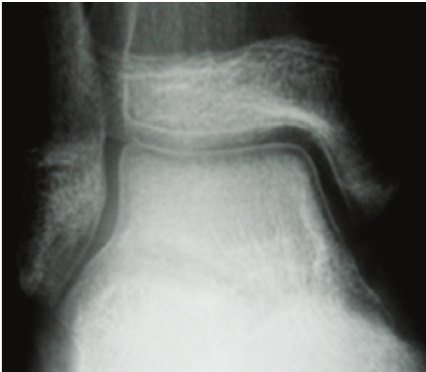
Figure 2: AP-radiograph of the ankle in a 12-year-old girl after im- mobilization after ankle sprain. Perfect subchondral bandlike osteo- porosis of the talar dome can be